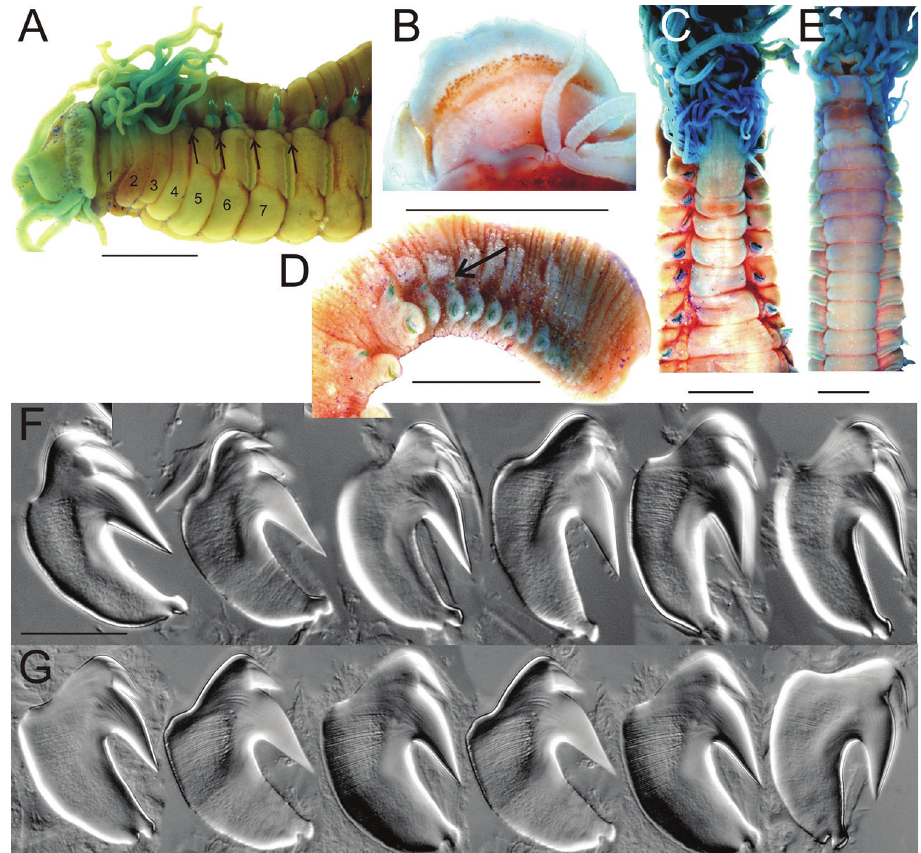
Figure 9. Thelepus parapari sp. n . A lateral view of anterior end (numbers of S are shown, nephridial papillae arrowed) B detail of anterior end, showing pigmented spots C dorsal view D view of posterior end (arrowed last segment with notochaetae) E ventral view F U1 uncini G U25 uncini. A, C–E holotype B MNCN 5700 F–H MNCN 5706. All worms stained with methylene blue. Scale bars: 1 mm ( A–E ); 20 μm ( F, G